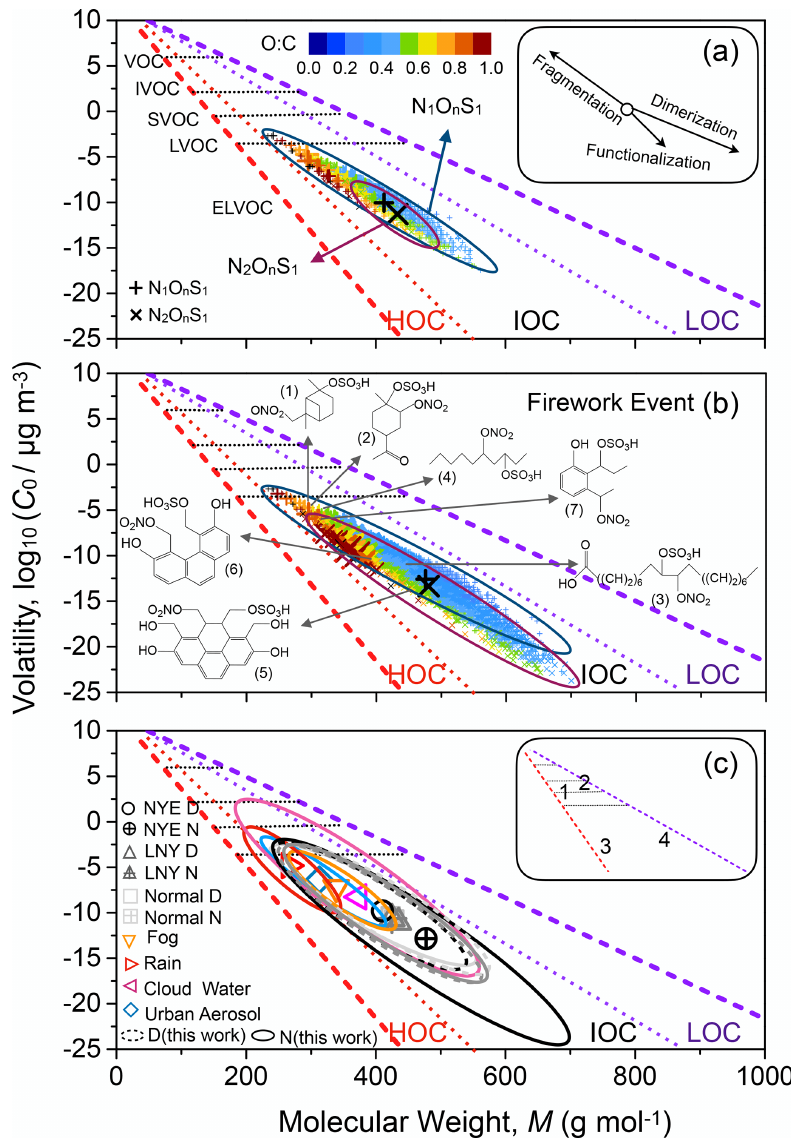
Figure 6. Molecular corridors and volatility characteristics for nitrooxy OSs in (a) NYE D and (b) NYE N. (c) Comparison of nitrooxy OSs in the present work with those reported in urban aerosols (Lin et al., 2012; O’Brien et al., 2014), cloud water (Zhao et al., 2013), rain (Altieri et al., 2009), and fog (Mazzoleni et al., 2010). The top right of (c) shows the characteristic reaction pathways with most probable kinetic regimes (1. aqueous-phase reaction; 2. simple gas-phase oxidation; 3. gas- or particle-phase autoxidation; and 4. particle-phase dimerization) (Shiraiwa et al., 2014). The boundary lines denote sugar alcohols C n H 2 n + 2 O n with O / C = 1 (red) and linear n -alkanes C n H 2 n + 2 with O / C = 0 (purple). The small plots denote the individual nitrooxy OSs color-coded by O / C ratio, and the larger ones show the surrogate nitrooxy OSs with the average values of M and C 0